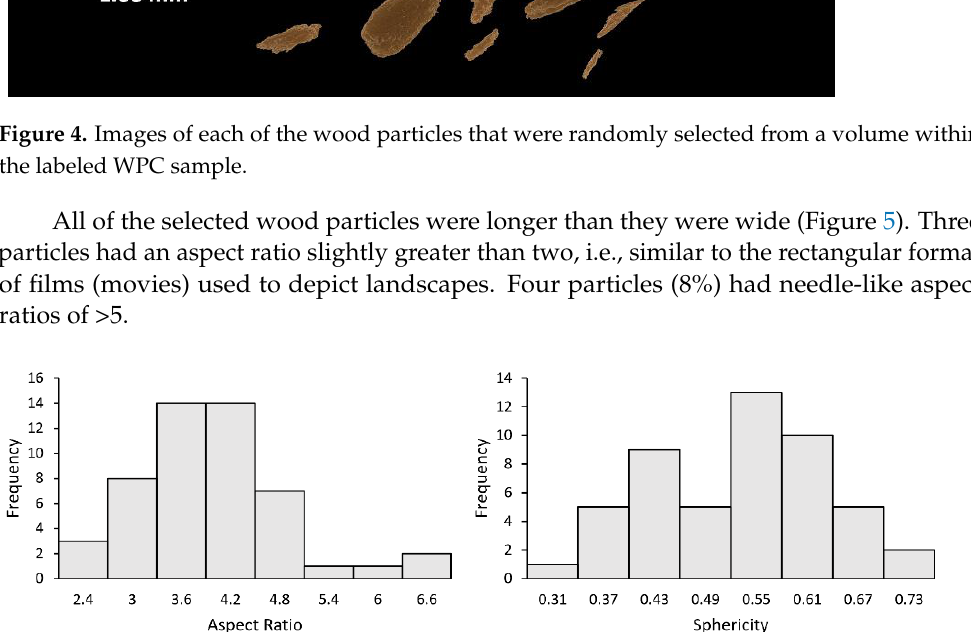
Figure 6. Shape descriptions of the selected 50 particles based on their length, breadth, and thickness (L:B:T) ratios. 4. Discussion Our results only partially support our hypothesis that aqueous sodium iodide is a suitable X-ray micro-CT contrast agent to help visualize the microstructure of a wood plastic composite. Sodium iodide labeling made it possible to: more clearly visualize wood and plastic in the WPC, quantify the levels of different phases (wood, plastic, zinc borate, and voids) in the composite, and measure the geometry of the wood reinforce- ment. These outcomes of labeling are noteworthy, but sodium iodide was not an ideal contrast agent because it altered the microstructure of the WPC. For example, it swelled wood particles closing interfacial voids, filled any remaining voids with liquid, and dis- solved zinc borate particles. Furthermore, the labeling process was lengthy and two sep- arate CT scans were needed to quantify the composite’s composition and analyze the shape of wood reinforcement. Future research should seek to overcome some of these limitations possibly by selecting a solvent for sodium iodide or an alternative halogenated chemical that does not swell wood or dissolve zinc borate. Wood or plastic could be la- beled prior to the manufacture of the WPC as has been done previously [21], which would eliminate the time-consuming step of impregnating wood with the contrast agent, but this approach is not suitable for visualizing the microstructure of commercial WPCs, which was one of the aims of this study